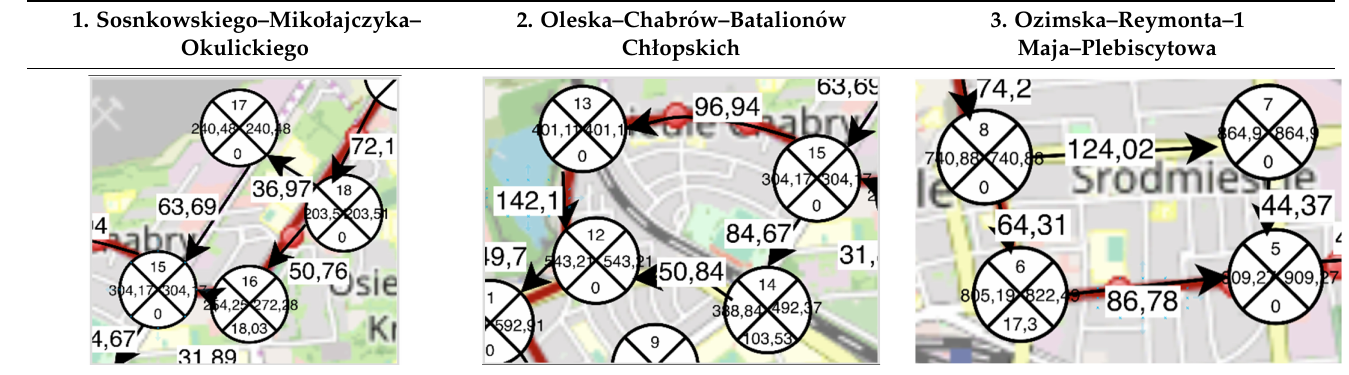
Table 4. Points of optimising bus service no. 3.